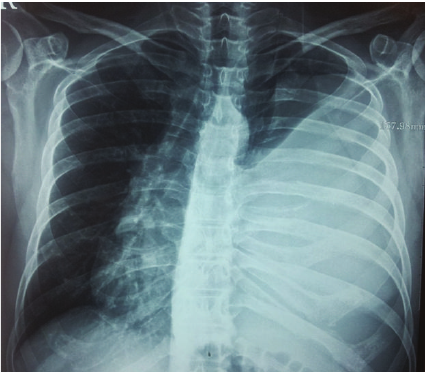
Figure 1: Chest X-ray shows a large left-sided mass density with obvious mediastinal shift including trachea and heart displacement.